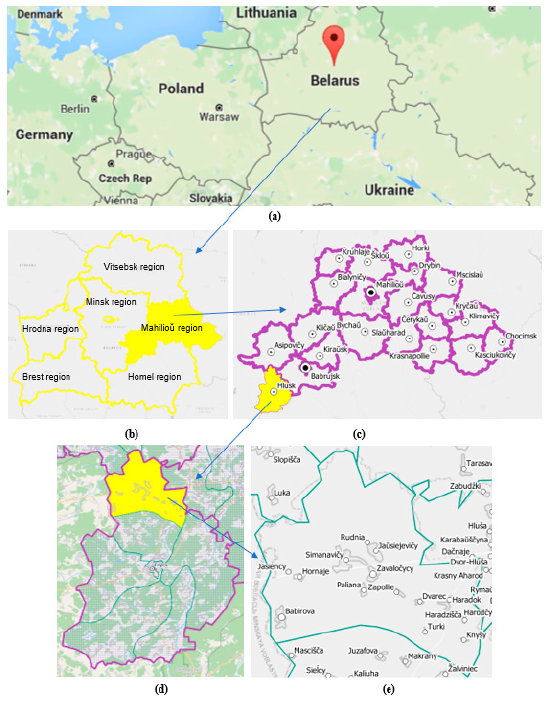
Figure 4. Location of the Zavaloˇcycy local council. Source: Own Work. ( a ) Belarus location, ( b ) Mahiliou region location, ( c ) Hlusk district location, ( d ) Zavaloˇcycy local council location, ( e ) Zavaloˇcycy local council map.